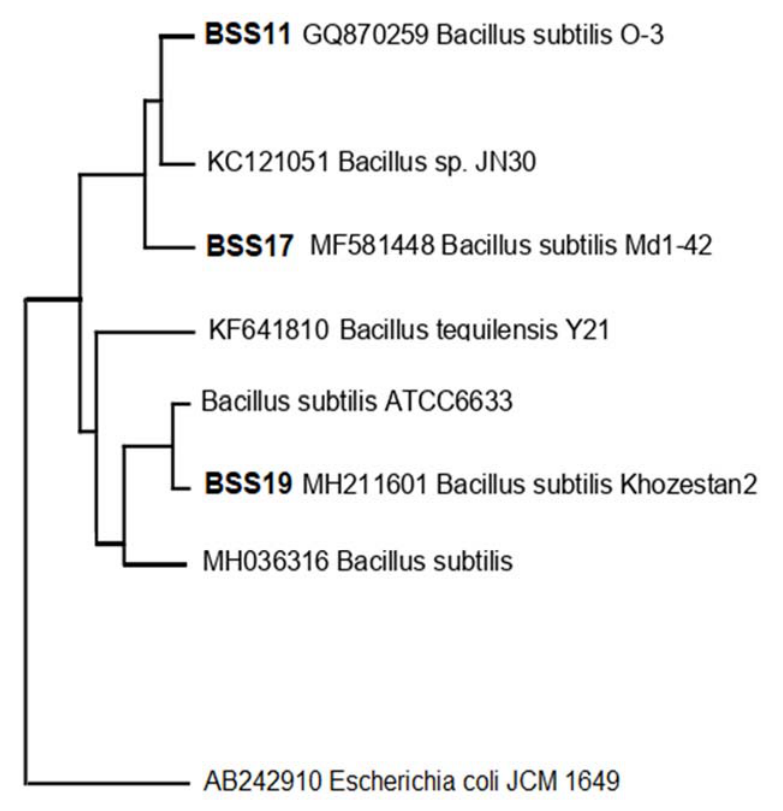
Figure 3. The phylogenetic tree using the neighbor-joining model was constructed based on 16S rRNA gene sequences representing different Bacillus subtilis subspecies, i.e., Bacillus subtilis O-3, Bacillus subtilis Md1-42, and Bacillus subtilis Khozestan2, respectively. As an outgroup, E. coli JCM 1649 (AB242910) was used.